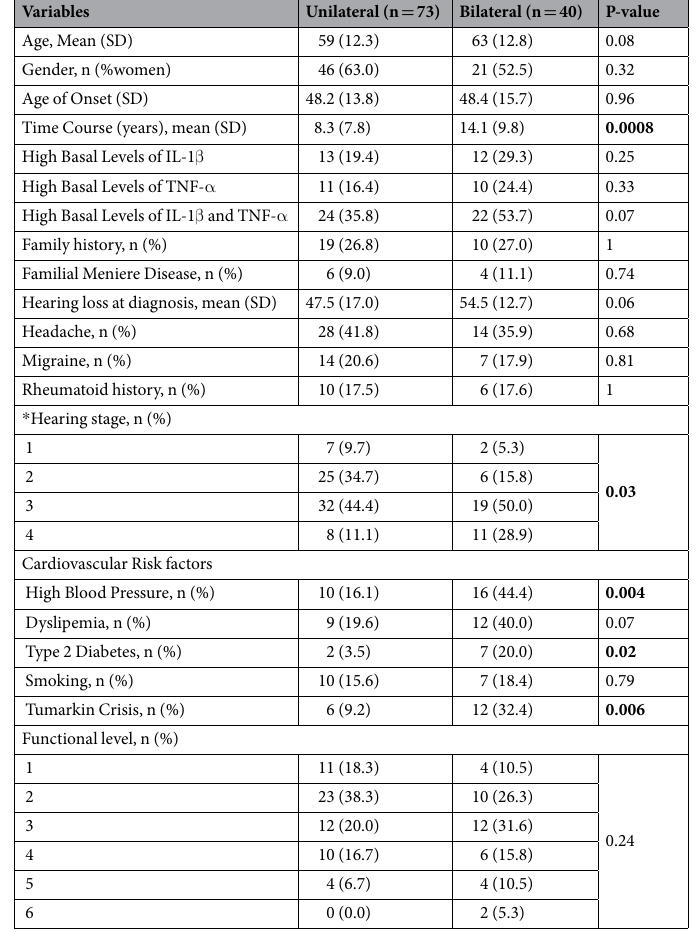
Table 1. Clinical features of patients with unilateral and bilateral Meniere disease included in the study Age, time course and hearing loss at diagnosis were compared by unpaired Student’s t test. Qualitative variables were compared by Chi-squared test. * Hearing stage, calculated for the worst ear in bilateral MD, and functional level, to estimate vertigo-associated disability, were measured according to the American Academy Otolaryngology 1995 guidelines and compared by ANOVA. P values in bold were statistically